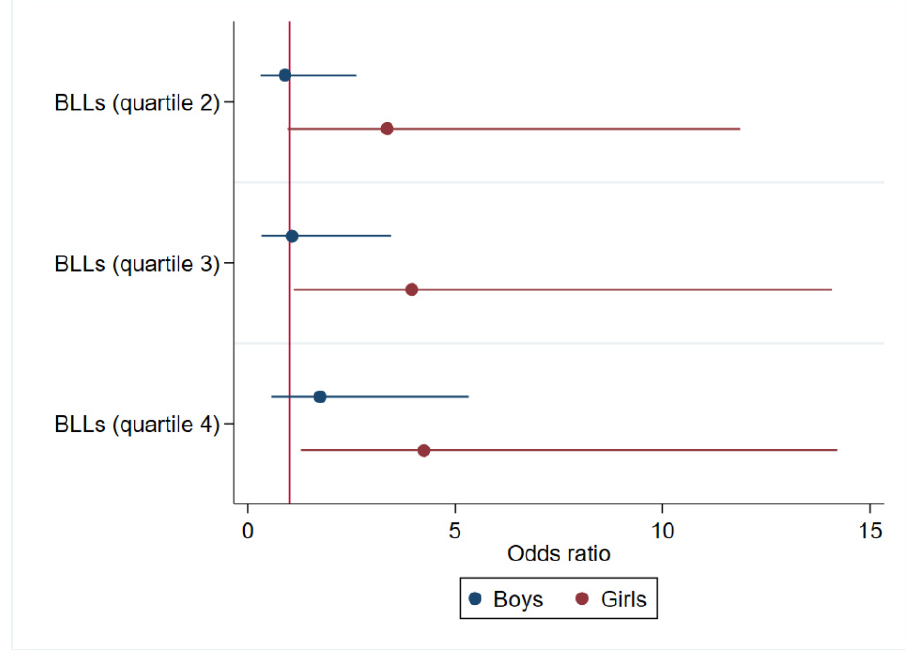
Figure 2. Adjusted odds ratio (OR) a and 95% confidence intervals for the associations between blood lead level quartiles* at age 1 year and stunting (HAZ < − 2) at age 4 years in Beninese children (Allada cohort) stratified by child sex b . BLLs: blood lead levels. P -trend † (boys: 0.27, girls: 0.02). *1st quartile (not shown) is the reference category. a adjusted for maternal characteristics (education, material possession/wealth score, estimated pre-conceptional BMI) and child characteristics (sex, low birth weight, weight, and iron deficiency at age 1). † P trends across quartiles of Pb were obtained by insert- ing its quartile as a continuous variable in the regression model. b n = 218 for boys; n = 200 for girls. Analyses of height and weight growth velocities showed no significant association between BLLs and velocities. However, a trend was observed across the quartiles of ex- posure (Table 3). Table 3. Regression coefficients (95% confidence intervals) for the associations between blood lead levels at age 1 year and growth velocities at age 4 and 6 years in Beninese children (Allada cohort). Age (year) BLLs Quar- tile * Weight Velocities (g/day) unadjusted β coeff. (95% CI)